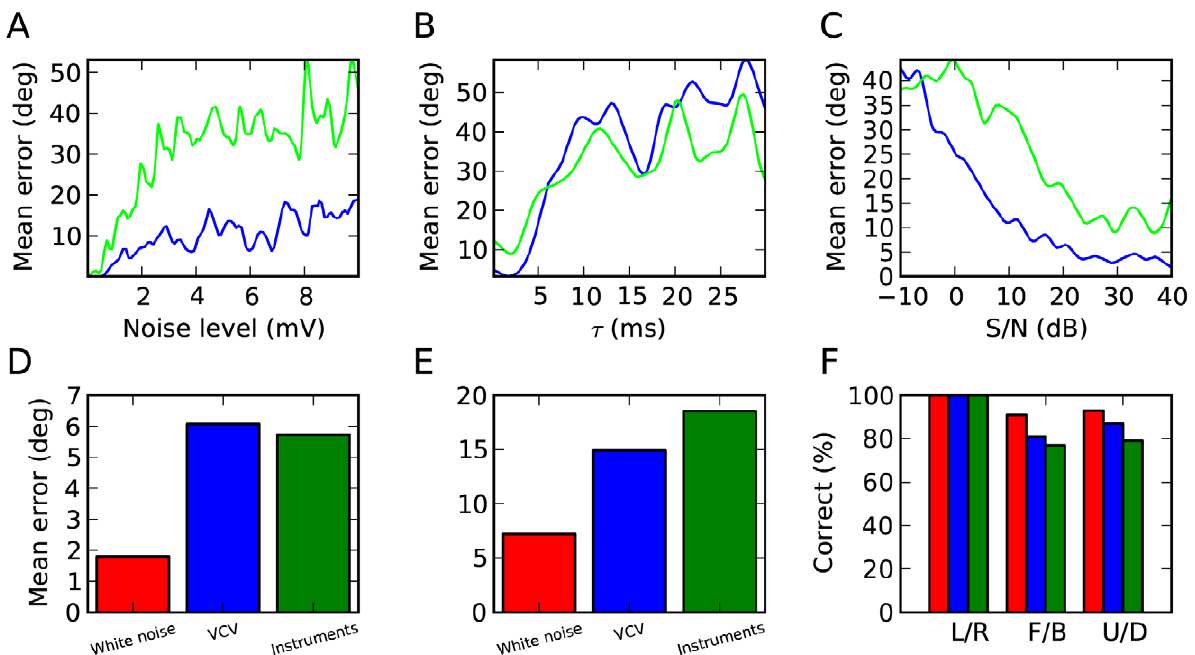
Figure 9. Robustness of the model. (A) Mean error in azimuth (blue) and elevation (green) as a function of the level of intrinsic noise in the model, measured as the standard deviation of the membrane potential. (B) Mean error as a function of the membrane time constant of coincidence detector neurons. (C) Mean error as a function of the signal to noise ratio, with uncorrelated white noise in both ears. (D, E, F) Performance of the model using AdEx neurons in place of LIF neurons (as in Figure